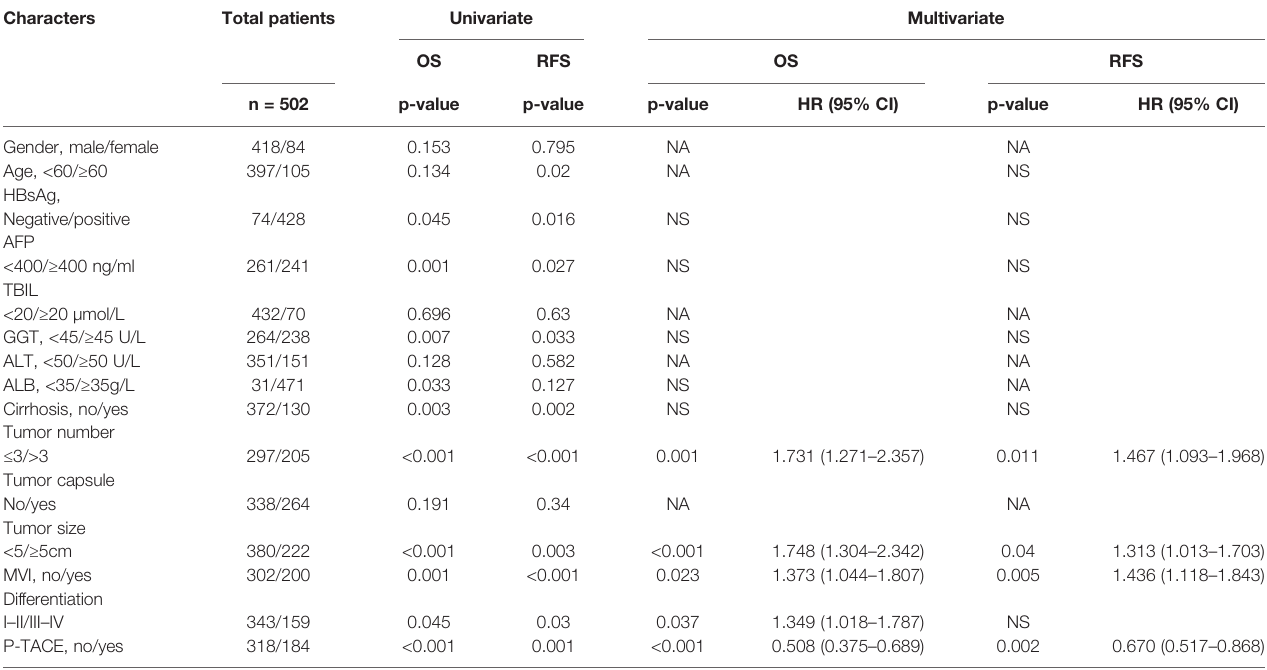
TABLE 2 | Univariate and multivariate analyses for OS and RFS in patients with 502